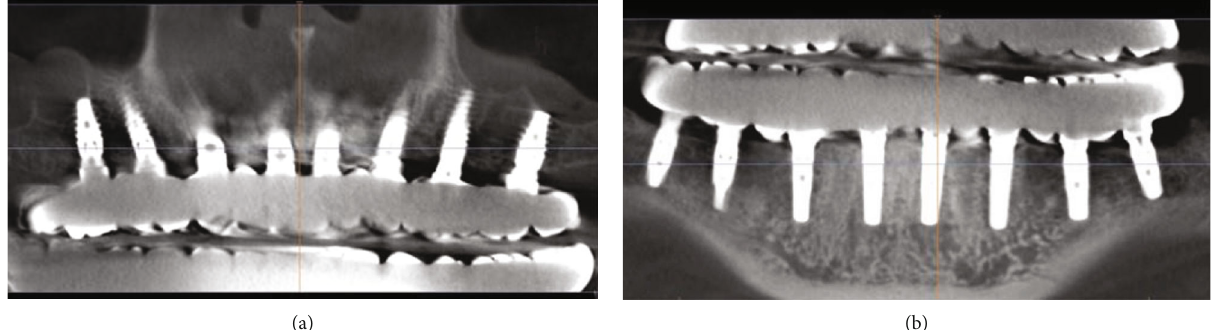
Figure 11: Condition and level stability of the bone tissue around dental implants after 12 month of prosthetics. (a) Is maxilla and (b) is